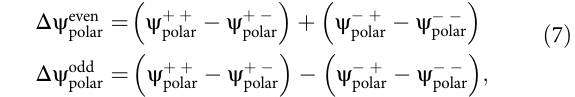
about 3.8 × 10 10 Am